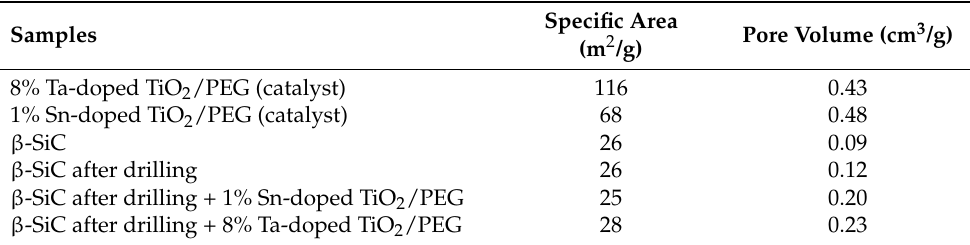
Table 2. Values of specific area and pores volume of β -SiC foams with or without catalyst compared to powder